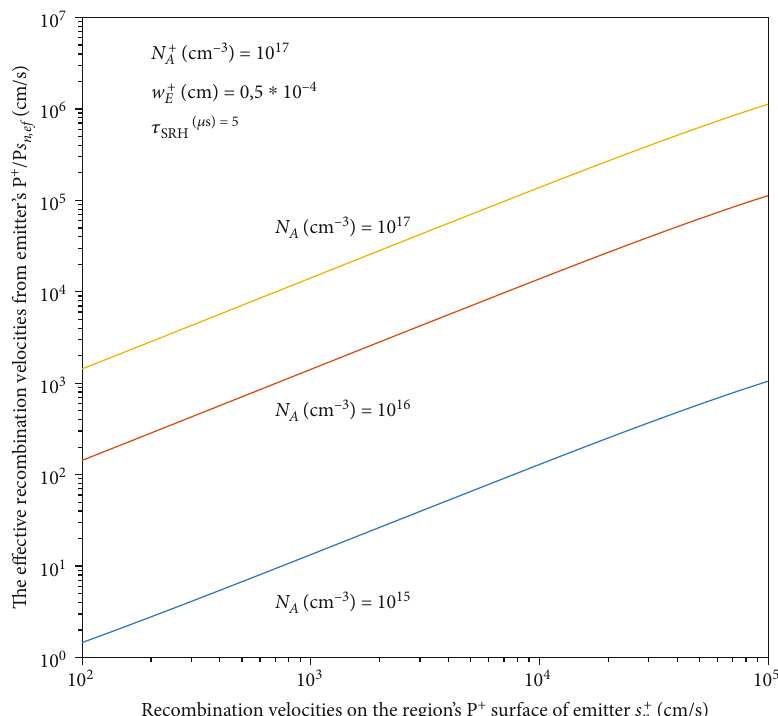
Figure 10: The e ff ective recombination velocities from the emitter ’ s interface P + /P s region ’ s P + surface of emitter s n + in the following conditions: N A + = 10 17 cm − 3 , w E + = 0 : 5 × 10 − 4 cm , and τ